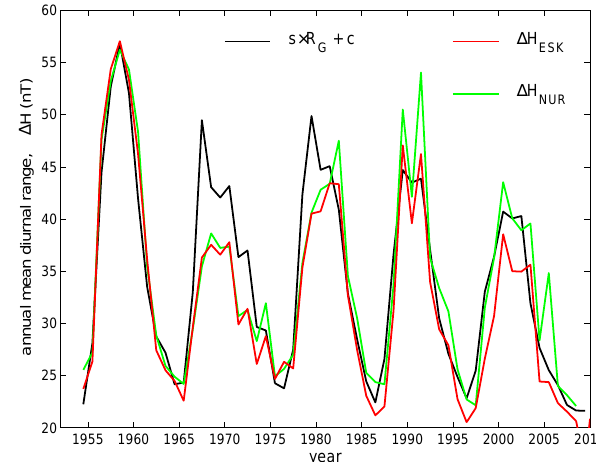
Fig. 2. The annual, mean diurnal range for modern day stations Nur- mijarvi (in green) and Eskdalemuir (in red), 1H NUR and 1H ESK for the period 1953–2008. Also shown (in black) are the best fit lin- ear regression to 1H NUR of the annual means of the group sunspot number R G taken from the Royal Greenwich Observatory observa- tions up to 1976 and the USAF/NOAA SOON network